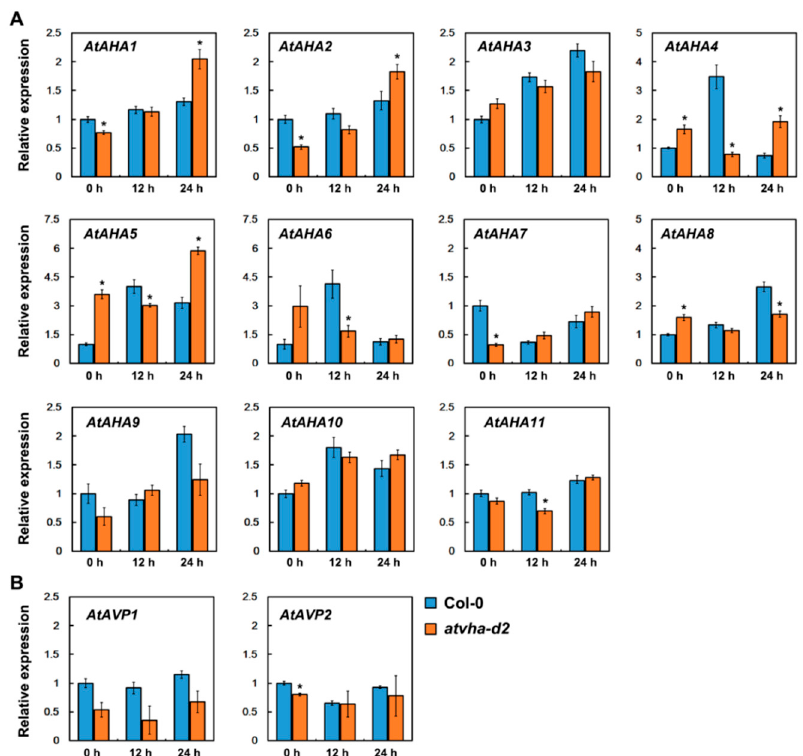
Figure 10. qPCR analysis of P-ATPase ( AtAHA ) and V-PPase ( AtAVP ) gene expression in Col-0 and the atvha-d2 mutant under normal and oxidative stress conditions. The P-ATPase gene family contains 11 members ( AtAHA1 to AtAHA11 ) ( A ) and the V-PPase contains two members ( AtAVP1 and AtAVP2 ) ( B ). Asterisks indicate a significant di ff erence between Col-0 and the atvha-d2 plants (* p < 0.05; Student’s t -test). Error bars indicate the SD ( n = 3).